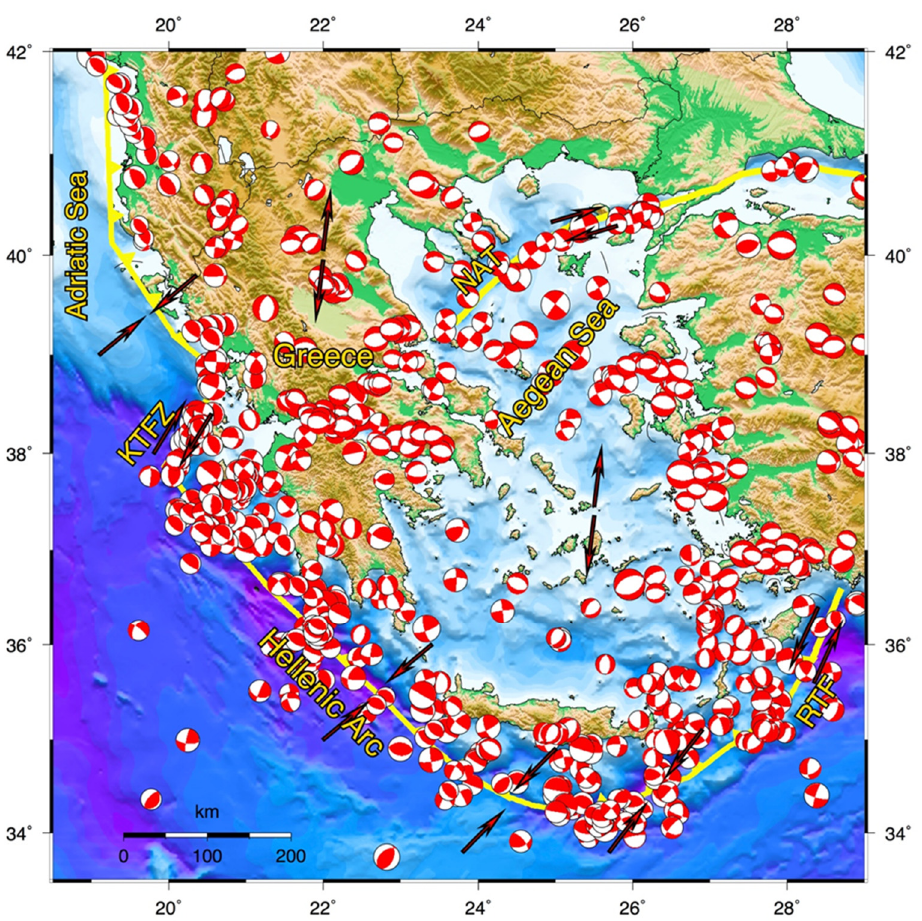
Figure 1. The major active boundaries (solid yellow lines) and their relative motions (red arrows) in the broader Aegean Sea area, along with the available focal mechanisms of earthquakes that occurred since 1976 as derived from the Global CMT database (Available online: www.globalcmt.org (last accessed on 30 April 2022)). Fault plane solutions are shown as equal area lower hemisphere projection (compressional quadrants are depicted in red).